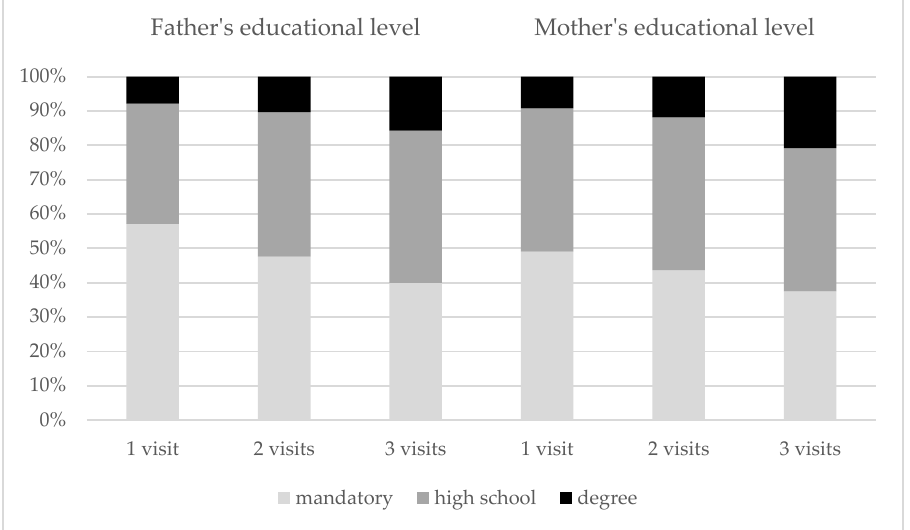
Figure 2. Percent distribution of outpatients’ adherence for father’s and mother’s educational level.